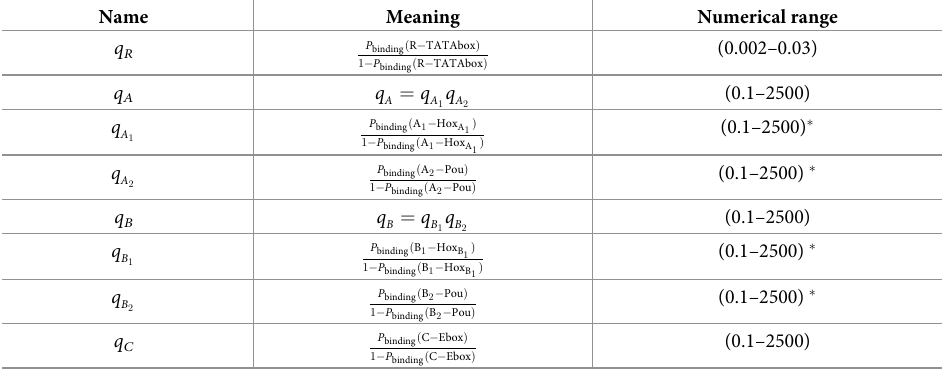
Table 2. Binding parameters: Names, meaning and numerical ranges. Parameters describing the TF-DNA bindings used in the model. In the cases marked with � , the extra constraint q numerical value of the parameters.